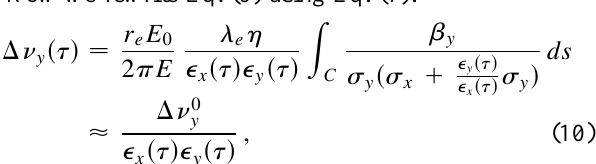
Bunch Train Gap